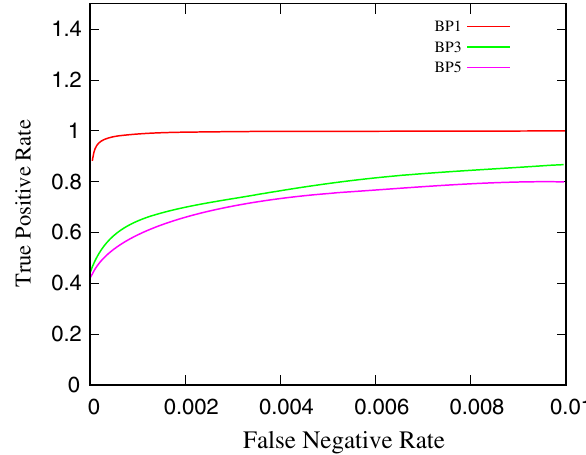
Fig. 9 ROC curves for BP1, BP3 and BP5